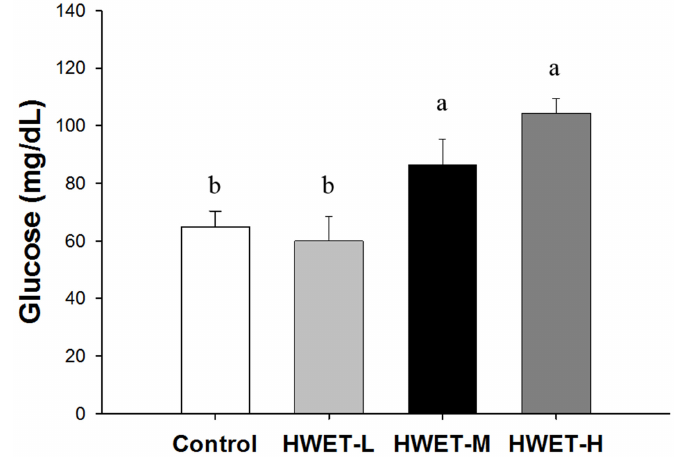
Figure 3. Effects of HWET treatments on serum glucose levels in mice after a swimming endurance test. Values are expressed as the mean ± SEM. Different letters indicate statistical difference, p < 0.05.